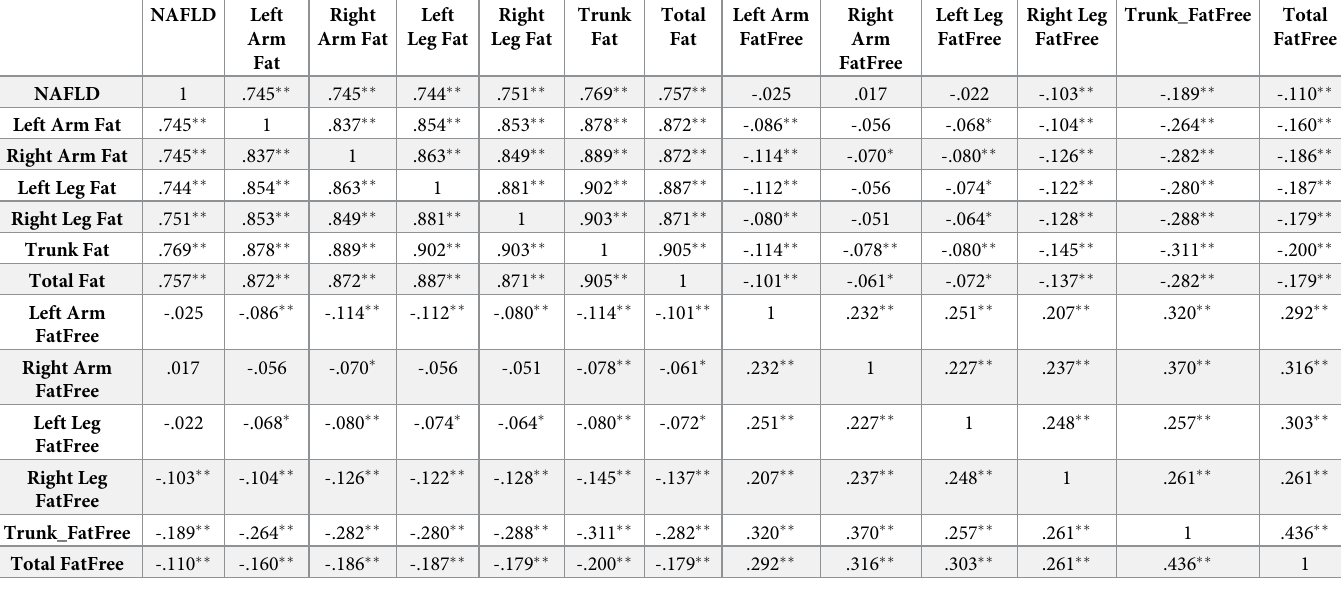
Table 3. Correlation # of fatty liver by body composition in men.